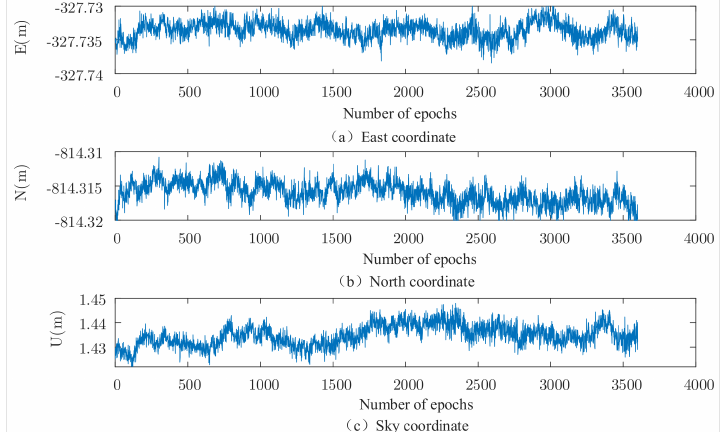
Figure 3. Measured data 1, three-dimensional baseline results of robust